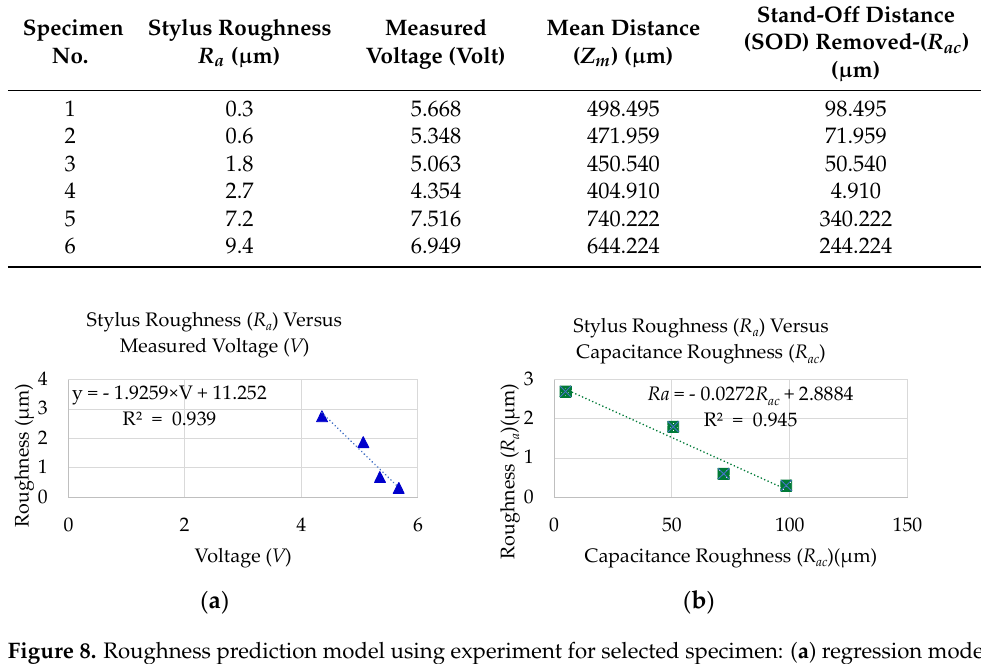
Table 4. Estimation of roughness for the remaining machined specimens using regression